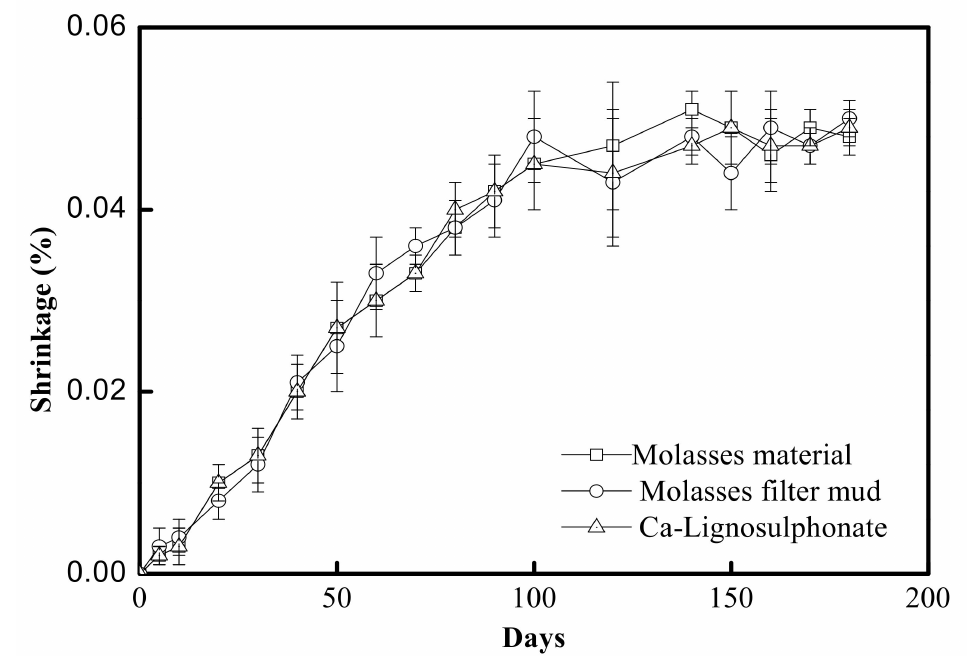
Figure 4. Monitoring drying shrinkage of concretes for admixture content of 0.4%.